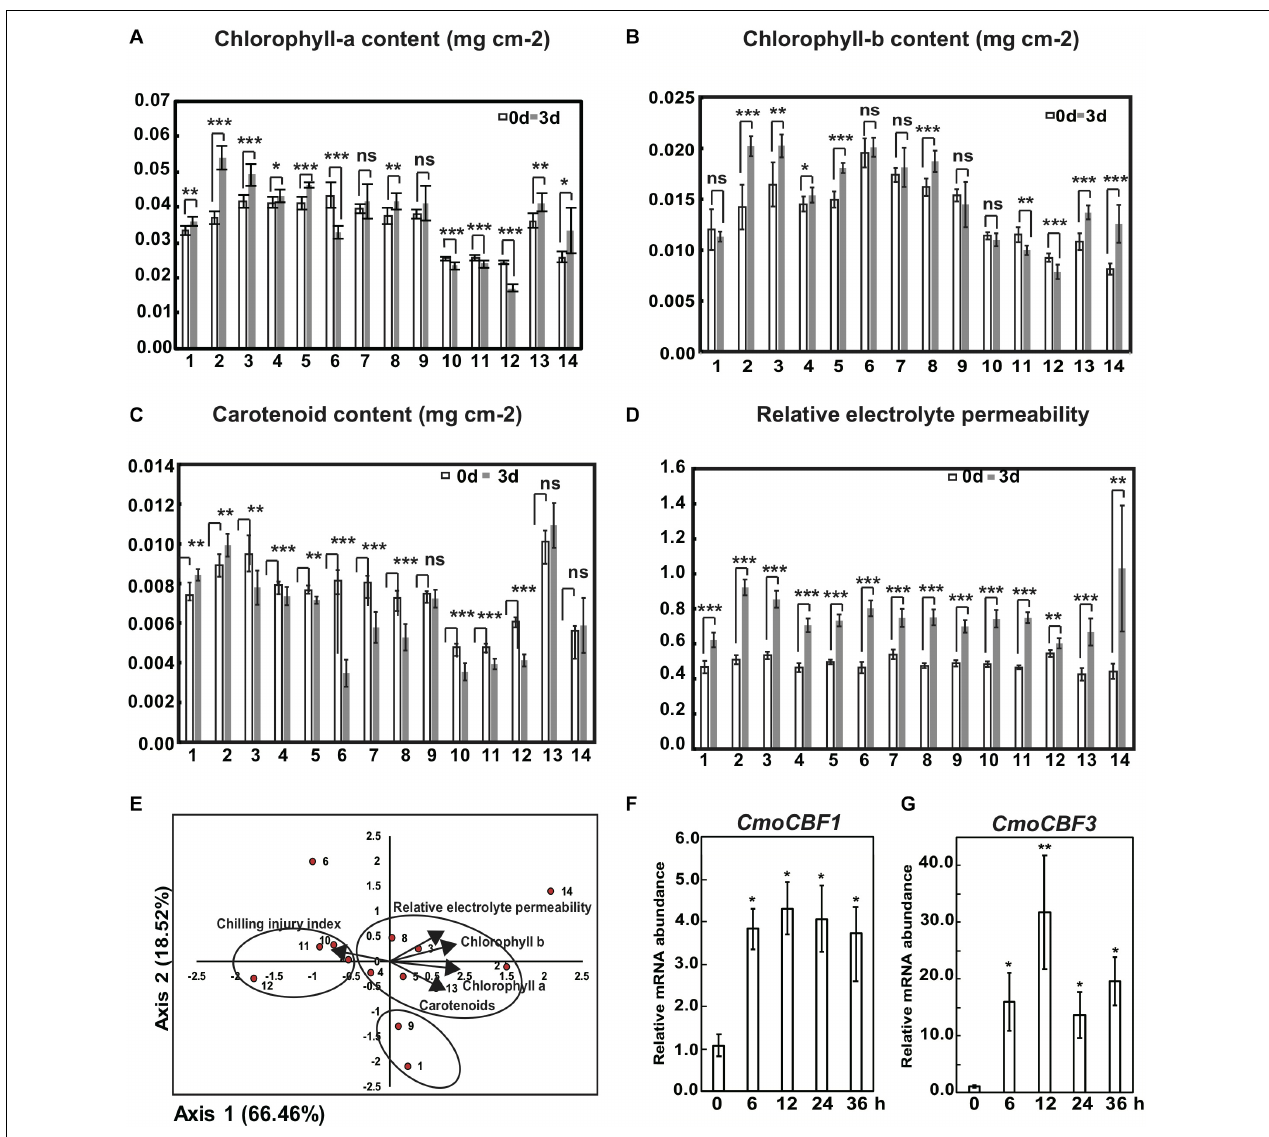
FIGURE 2 | Physiological evaluation and principal component analysis (PCA) of 14 pumpkin rootstock varieties under cold treatment. The content of chlorophyll-a (A) , chlorophyll-b (B) and carotenoids (C) of 14 pumpkin seedlings after 3rd of chilling. (D) Statistics for relative electrolyte permeability (REP) of the first true leaves of seedlings from 14 pumpkin rootstock varieties after 3 d of chilling. (E) PCA for the content of chlorophyll-a, chlorophyll-b and carotenoids and REP and CII indices for 14 pumpkin rootstock varieties. Relative mRNA abundance of CmoCBF1 (F) and CmoCBF3 (G) in “ Qianglishi ” under chilling stress. Three replicates of the pooled first true leaves and 9–12 individual seedlings per each replicate were used for the analysis. Asterisks indicate highly significant differences compared with values from seedlings not exposed to chilling using the t -test for independent variables. The detailed information of different numbers representing different pumpkin commercial varieties was listed in Supplementary Table S1 . Significance: *** p < 0.001; **0.001 < p < 0.05; *0.05 < p < 0.01; ns: p > 0.01. Error bars indicate